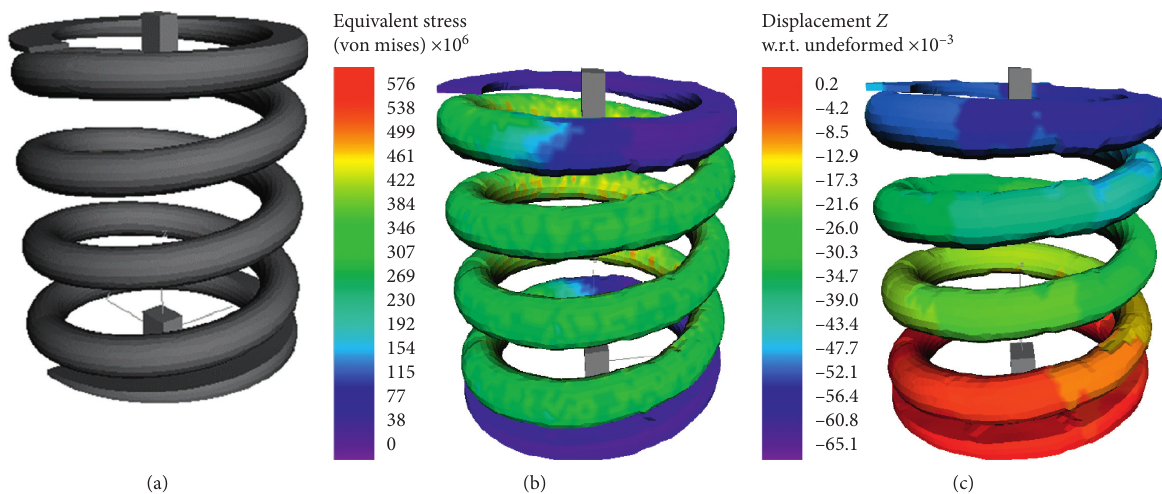
Figure 6: Simulation of dynamic characteristics. (a) Equivalent model of flexible spring. (b) The cloud diagram of Von Mises stress. (c) The cloud diagram of displacement.